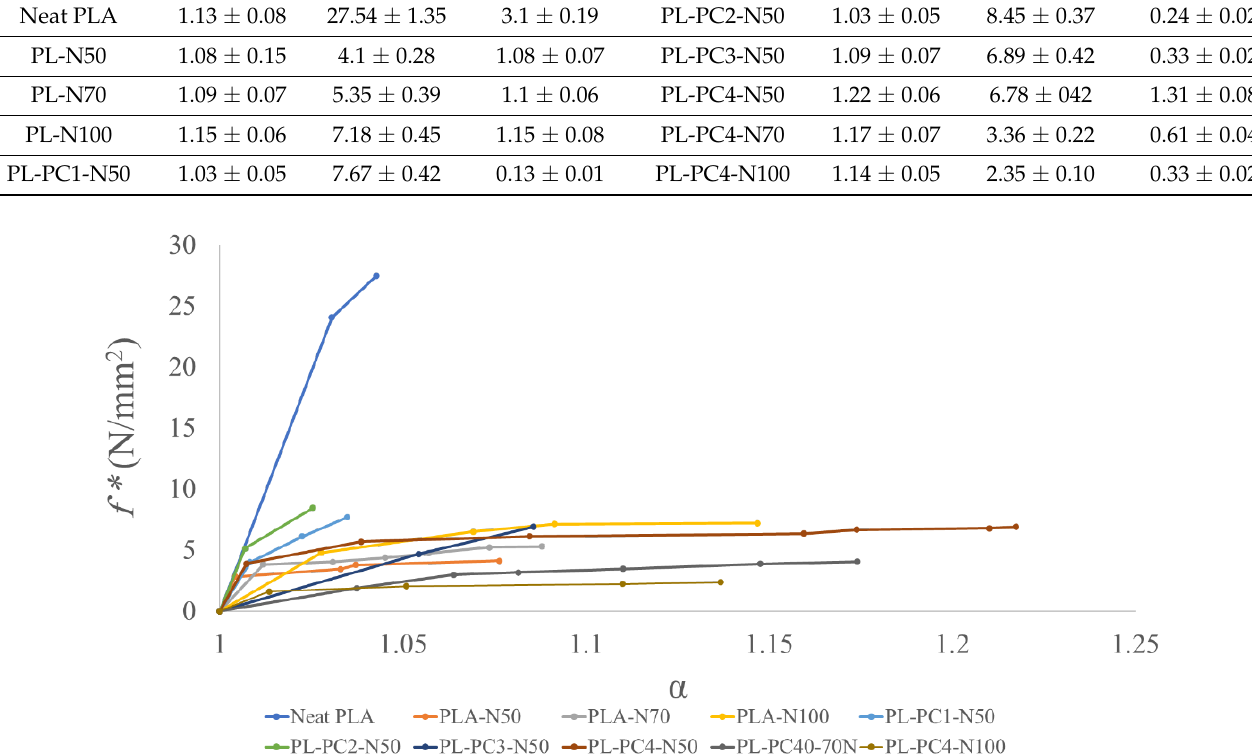
Figure 3. Stress–strain graph of neat PLA and porous PLA and PCL/PLA films.